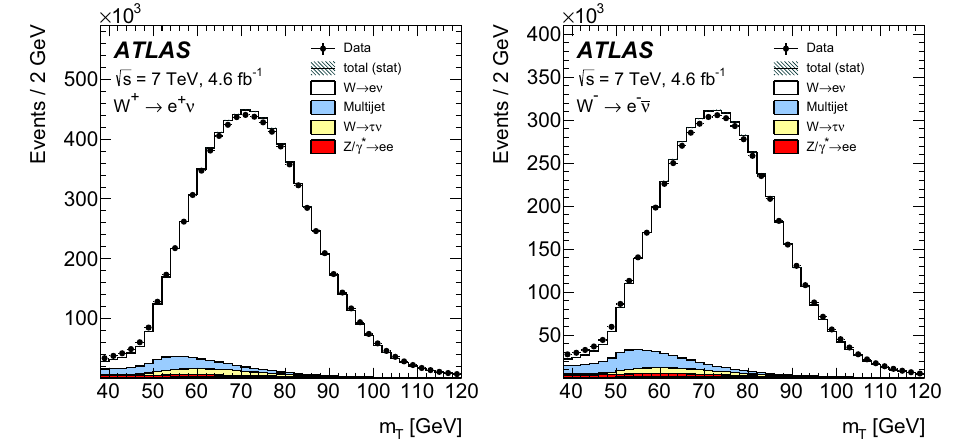
mated yield of multijet events. The sum of all expected background and signal contributions is shown as a solid line with a hashed band detail- ing the statistical uncertainty and labelled “total (stat)”. The legend lists only background sources with a visible contribution